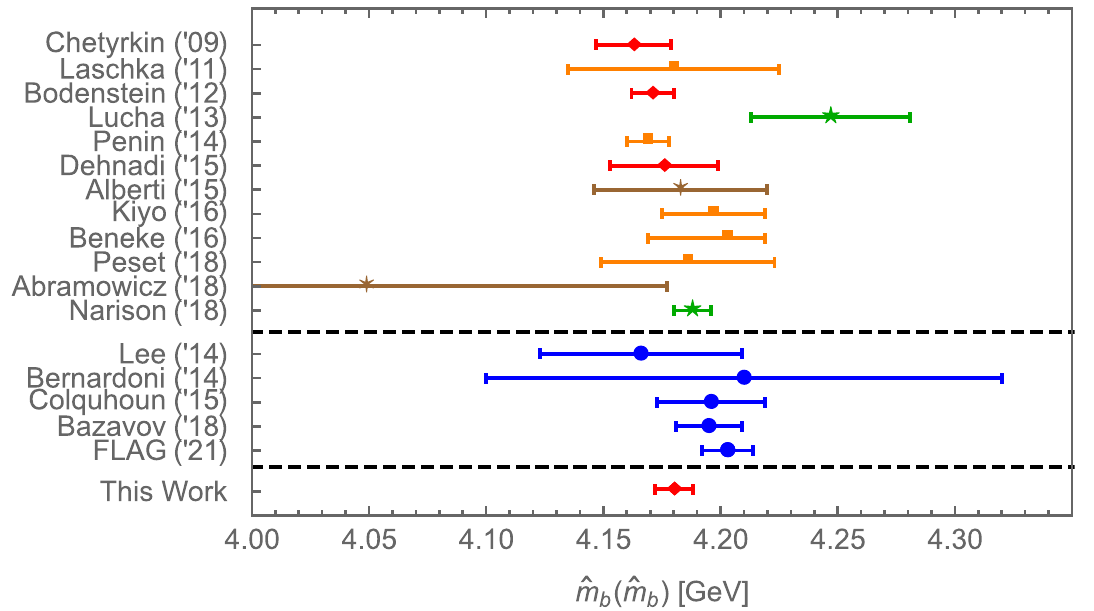
Fig. 7 Recent bottom quark mass determinations from phenomenological studies (upper part; red, orange, brown and green symbols) and lattice calculations (lower part; blue points). See text for details and references